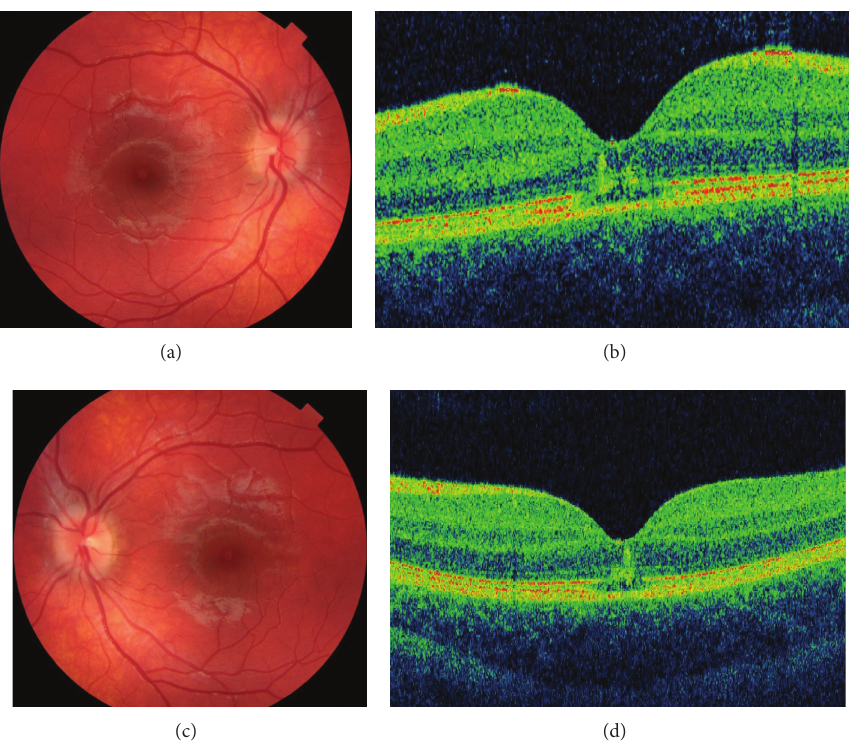
Figure 1: Ophthalmoscopy of the right and left eye of Case 1, showing a normal macula with a slight reduction of the foveal reflex (a, c). SD-OCT showed a maintained foveal contour, juxtafoveal microcystic cavities in the outer retina, increased foveal rod-shaped full-thickness hyperreflectivitythatextendedfromtheoutersegmentsofthephotoreceptorsandRPEtotheinnerlayeroftheretina,andaslightinterruption of the external limiting membrane and of the inner and outer segment (IS/OS) junctions, with disorganized material in the “vitelliform space” (b,